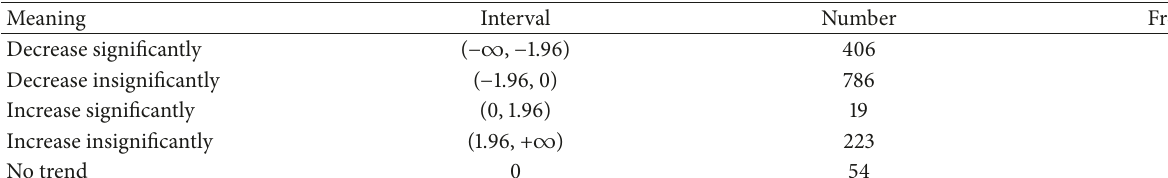
Table 2: Results of the MK trend test with a running approach.